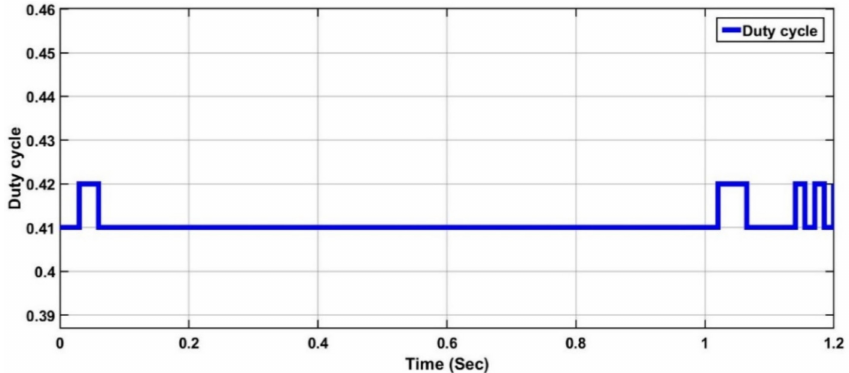
Figure 34. V pv of the Firefly Algorithm for Case-3.